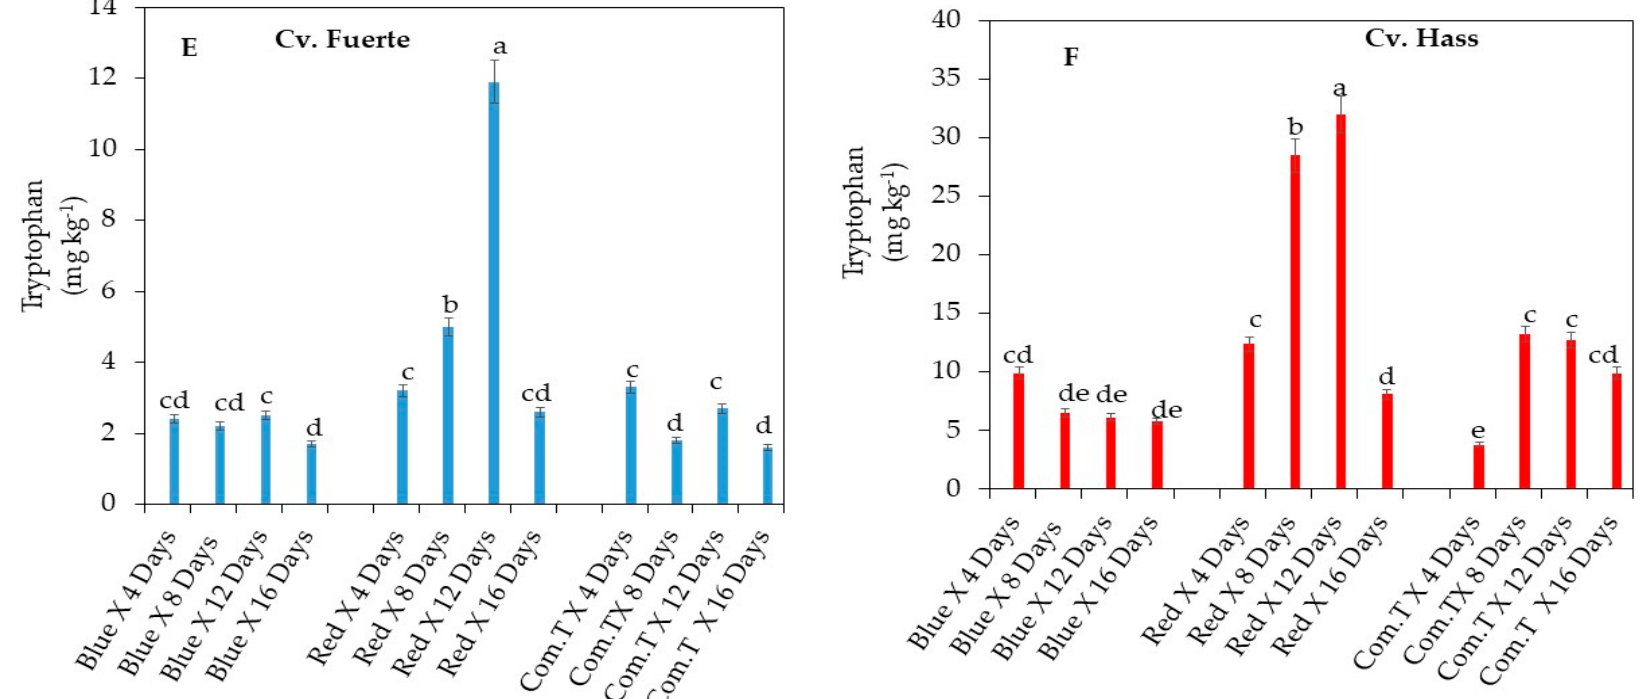
Figure 6. Influence of LED light treatments on ( A ) coumaric acid hexoside in cv. Fuerte and ( B ) coumaric acid hexoside in cv. Hass. Influence of LED light treatments on ( C ) 3-feruloyl quinic acid in cv. Fuerte and ( D ) 3-feruloyl quinic acid in cv. Hass. Influence of LED light treatments on ( E ) tryptophan in cv. Fuerte and ( F ) tryptophan in cv. Hass. Mean ± standard deviation values for each bar were calculated based on five fruits. Number of replicates per treatment n = 5. Mean values of bars marked by different letters were significantly different at p < 0.05, according to Fisher’s protected LSD test. Blue, blue LED light; Red, red LED light; Com.T, commercial treatment.